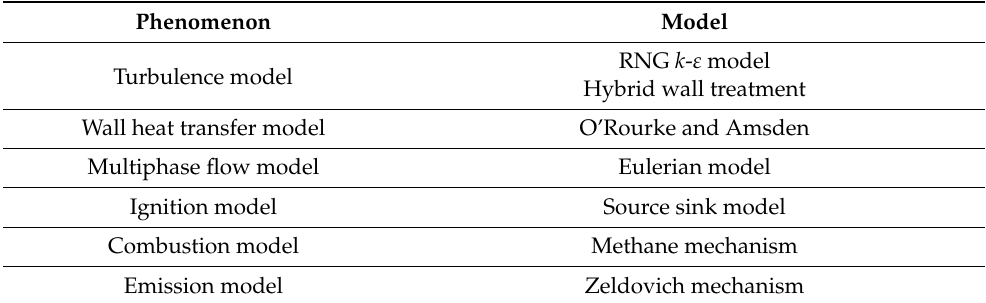
Table 4. The models in the simulation.